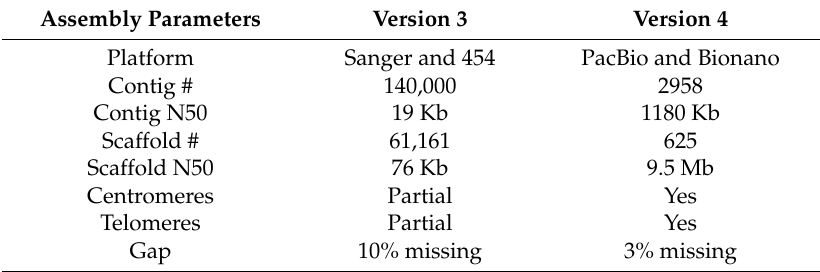
Table 3. Comparison of the reference maize genome assembled by different sequencing